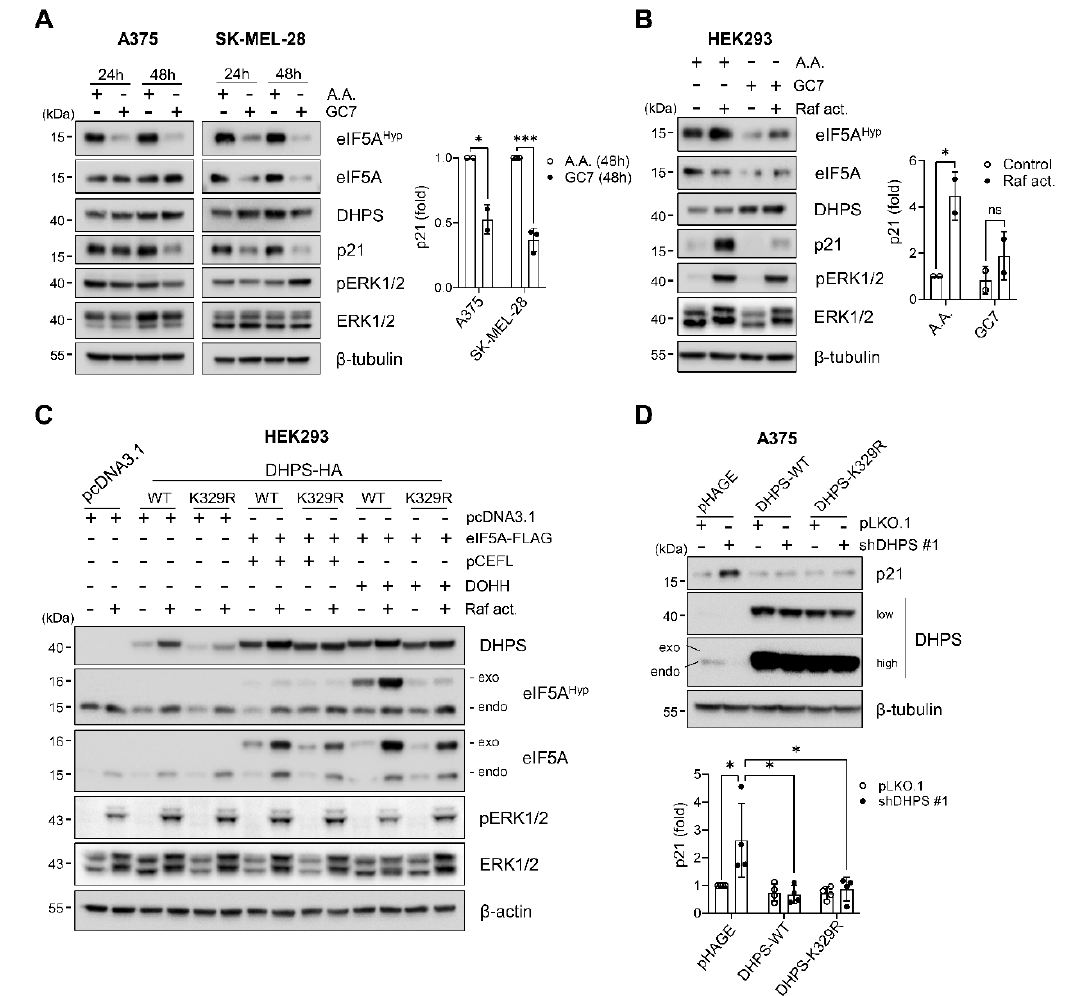
Figure 4. Hypusinating activity is not necessary for DHPS to regulate p21 CIP1 levels. ( A ) Western blots of total lysates of cells treated with 10 µ M GC7 for indicated time periods. Equal volume of acetic acid (A.A.) was used as the vehicle control. (right) Densitometry of p21 CIP1 normalized to β -tubulin. ( B ) Western blots of total lysates of HEK293- ∆ Raf:ER treated with 1 µ M tamoxifen (Raf act.) with or without 10 µ M GC7 for 24 h. (right) Densitometry of p21 CIP1 normalized to β -tubulin. ( C ) Western blots of total lysates of HEK293- ∆ Raf:ER cells co-transfected for 48 h with pcDNA3.1 plasmids expressing wild type DHPS (WT), DHPS-K329R (K329R), and C-terminal FLAG-tagged eIF5A (eIF5A-FLAG), and pCEFL plasmid expressing DOHH, and then treated with 1 µ M tamoxifen (Raf act.) for an additional 24 h. Empty vectors were used as the control. β -actin is the control for equal protein loading. Exo and endo indicate exogenous eIF5A and endogenous eIF5A, respectively. ( D ) Western blots of total lysates of cells co-infected for 5 days with pLKO.1-shDHPS virus and pHAGE viruses expressing DHPS constructs engineered to avoid shDHPS. (bottom) Densitometry of p21 CIP1 normalized to β -tubulin. Data are mean ± SD of biological duplicate and triplicate. * p < 0.05 and *** p < 0.001 by two-tailed Student t